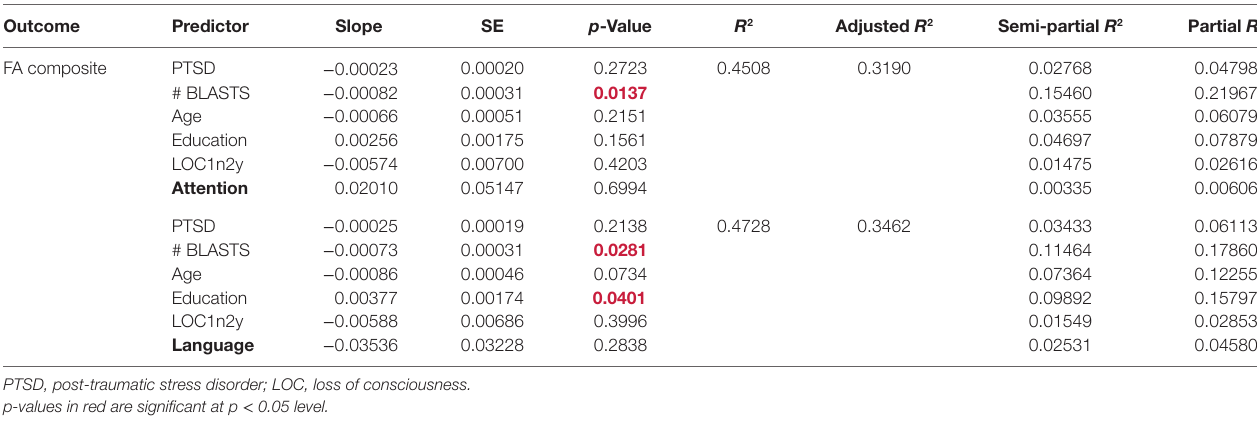
TaBle 6 | Predicting composite fractional anisotropy (Fa)